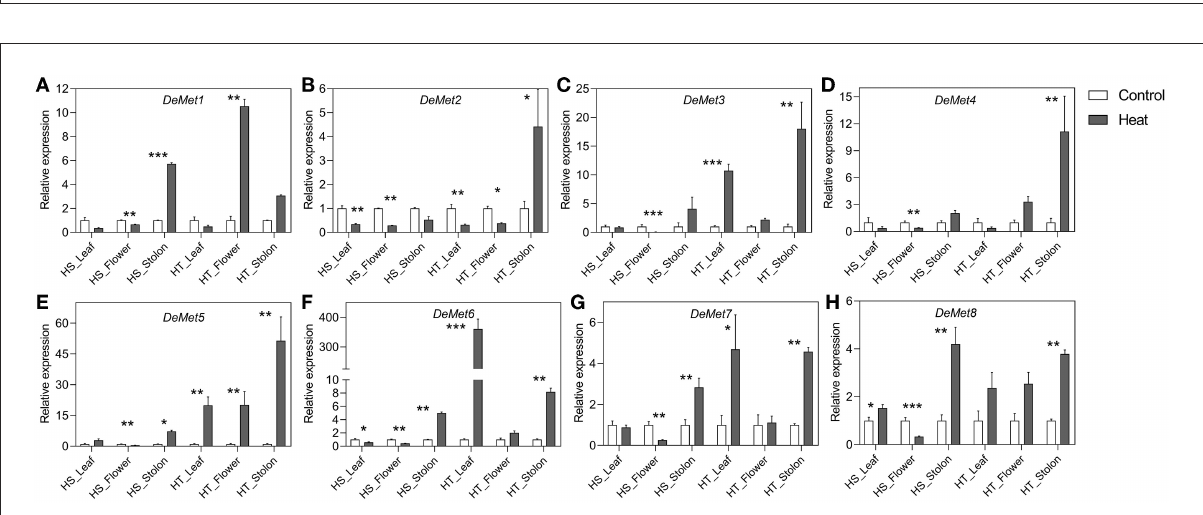
FIGURE6 (A–H) Relative expression levels of potato DeMet genes in different tissues in heat sensitive (HS) and tolerant (HT) genotypes under high temperature stress. Three biological samples were measured with three technical replicates. The fold change in RNA levels was calculated as the 2– 11 Ct value relative to the mean values obtained in the leaf, flower and stolon samples (set at a value of 1.0). Standard errors of the means are shown with one, two and three asterisks indicating significant differences ( p < 0.05, p < 0.01, p < 0.001, respectively) using a student’s t